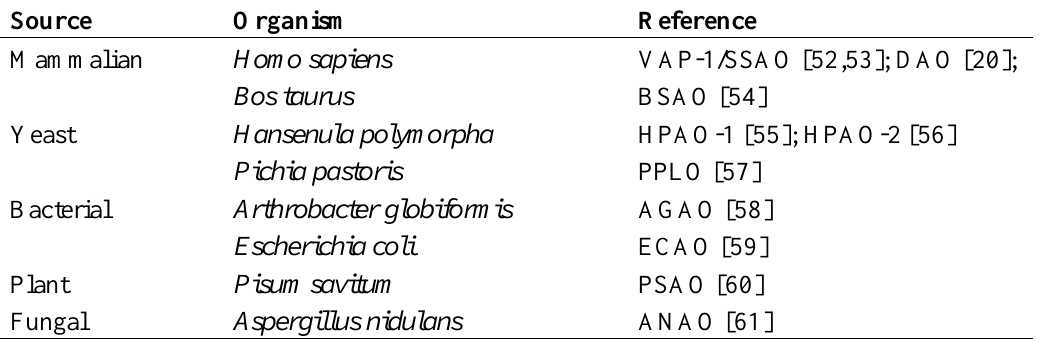
Table 1. TPQ-containing CAOs with available X-ray crystal structures.